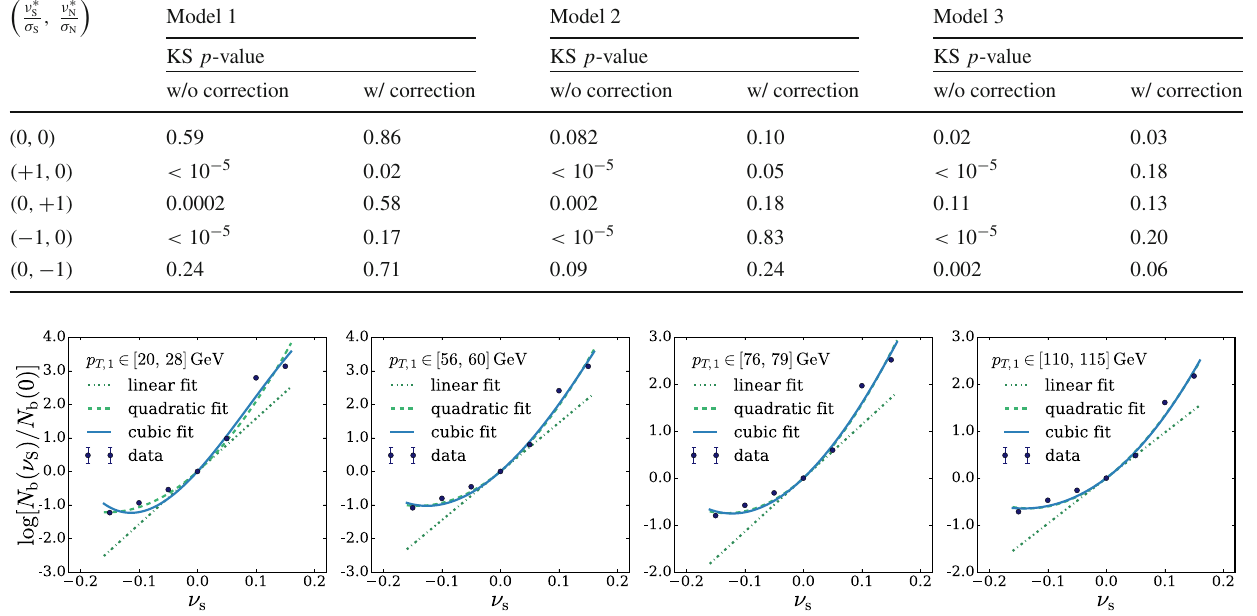
Fig. 17 The dependence on ν s of log N b (ν s )/ N b ( 0 ) in selected bins of the transverse momentum distribution for M 12 > 100 GeV. The dots represent the true value of the log-ratio. The linear and quadratic fits